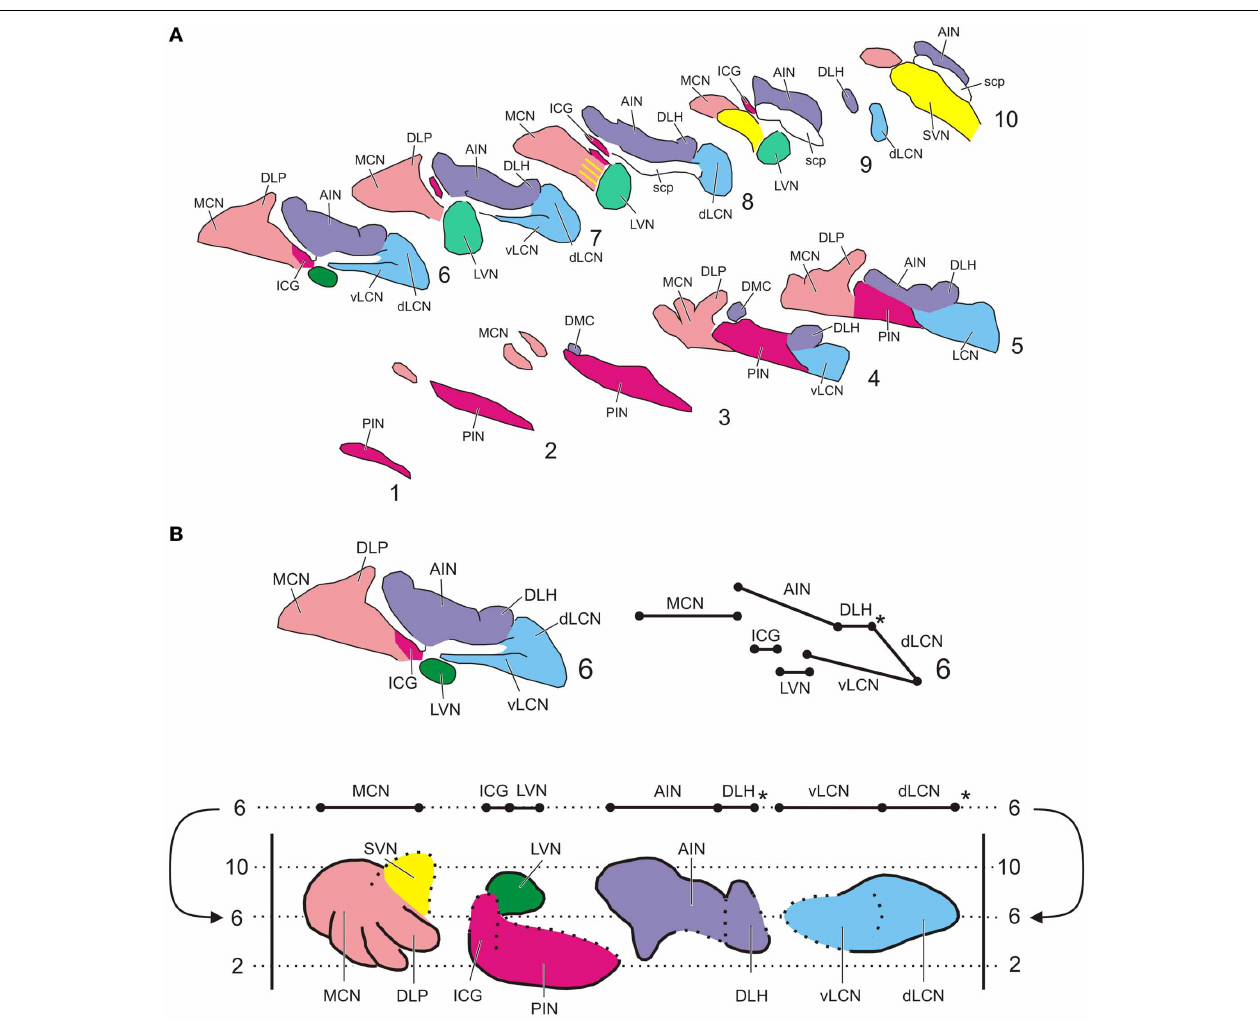
FIGURE 1 | Standardized diagrams of the right hand cerebellar nuclear complex of the rat. (A) Series of transverse sections from caudal (1) to rostral (10) separated by 160 micron (adapted after Ruigrok and Voogd, 2000). Medial is to the left. (B) Construction of the standardized diagram of a dorsal view of the separated cerebellar nuclei (adapted after Ruigrok and Voogd, 2000). Upper diagrams show how level 6 of the transverse diagrams is transposed into the bottom diagram. Note that the dorsal and ventral parts of the LCN are